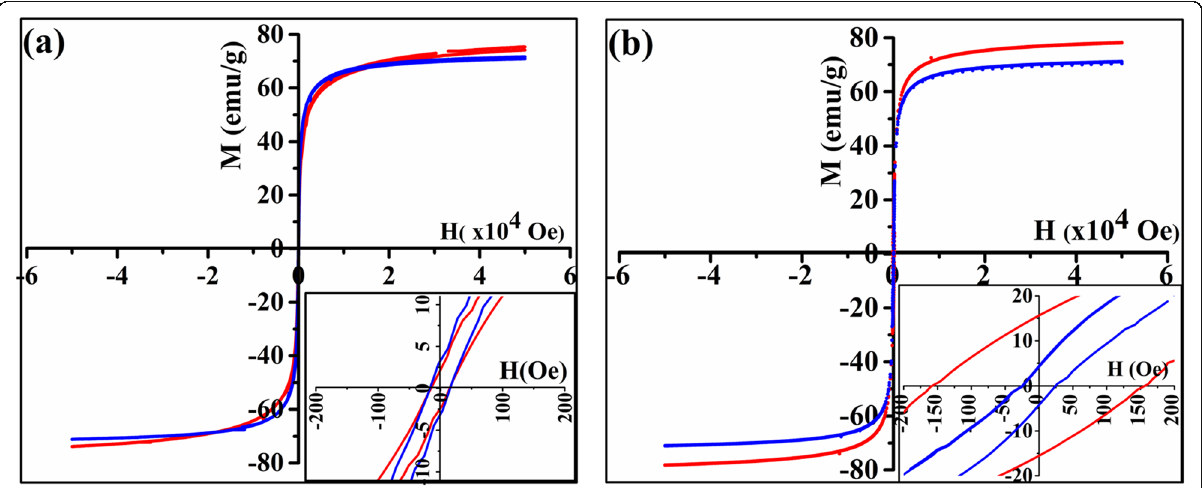
Fig. 6 Hysteresis loops for pristine Fe 3 O 4 nanoparticles before (blue) and after heating (red) up to a 600 K and b 900 K (insets show magnetization at low magnetic